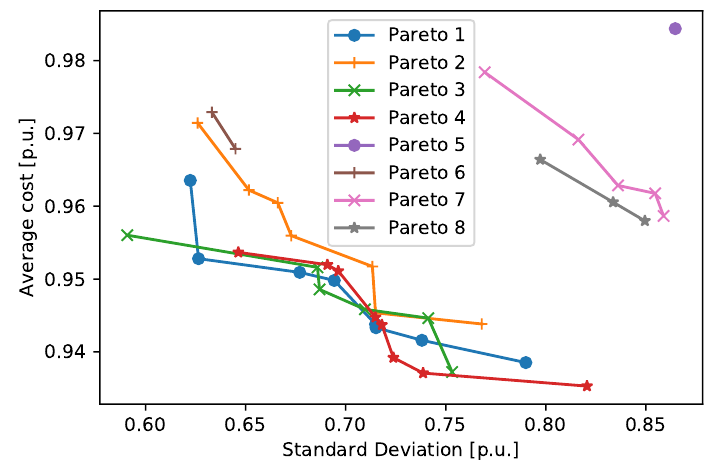
Figure 11. Comparison of all Pareto points.